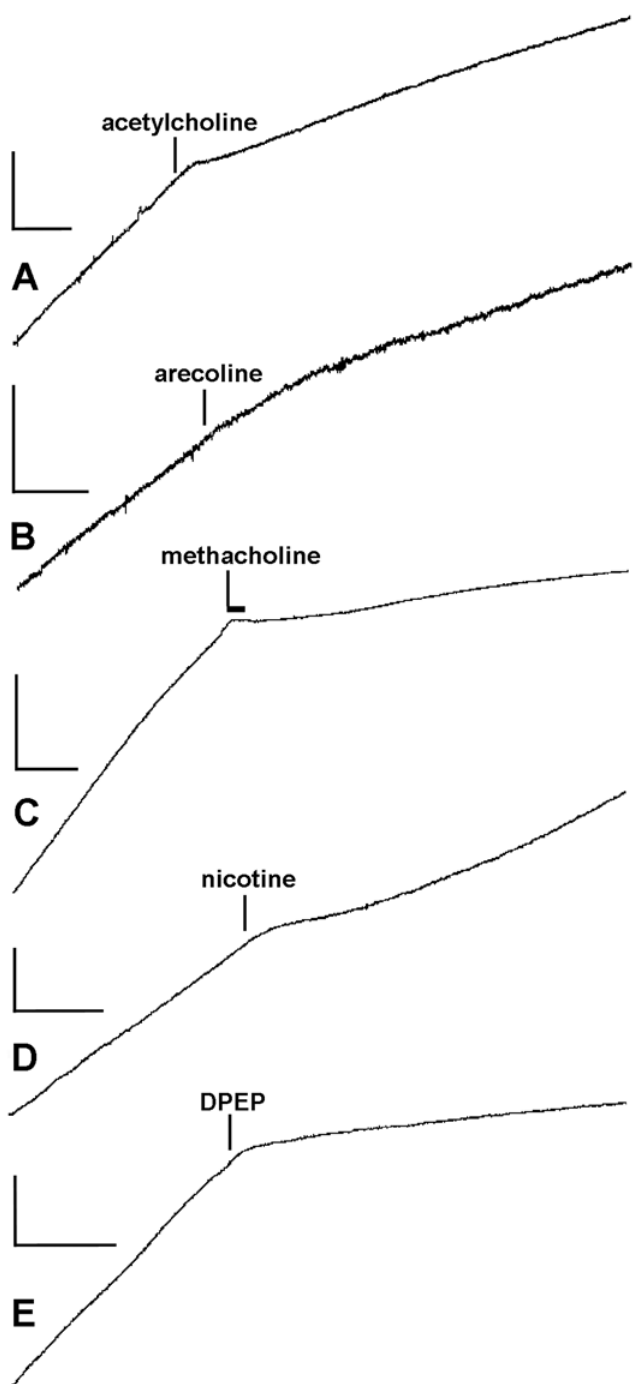
Fig 5. Recordings showing representative effects of cholinergic agonists (all 1 mmol l -1 ). In all cases except C, after the agonist was added it was present to the end of the recording; in C, methacholine was present for only the time period indicated by the horizontal bar, after which it was washed out. Vertical and horizontal scalebars indicate respectively extension and time: (A) 0.2 mm, 60 s; (B) 0.1 mm, 30 s; (C) 0.5 mm, 30 s; (D) 0.2 mm, 30 s; (E) 0.2 mm, 30